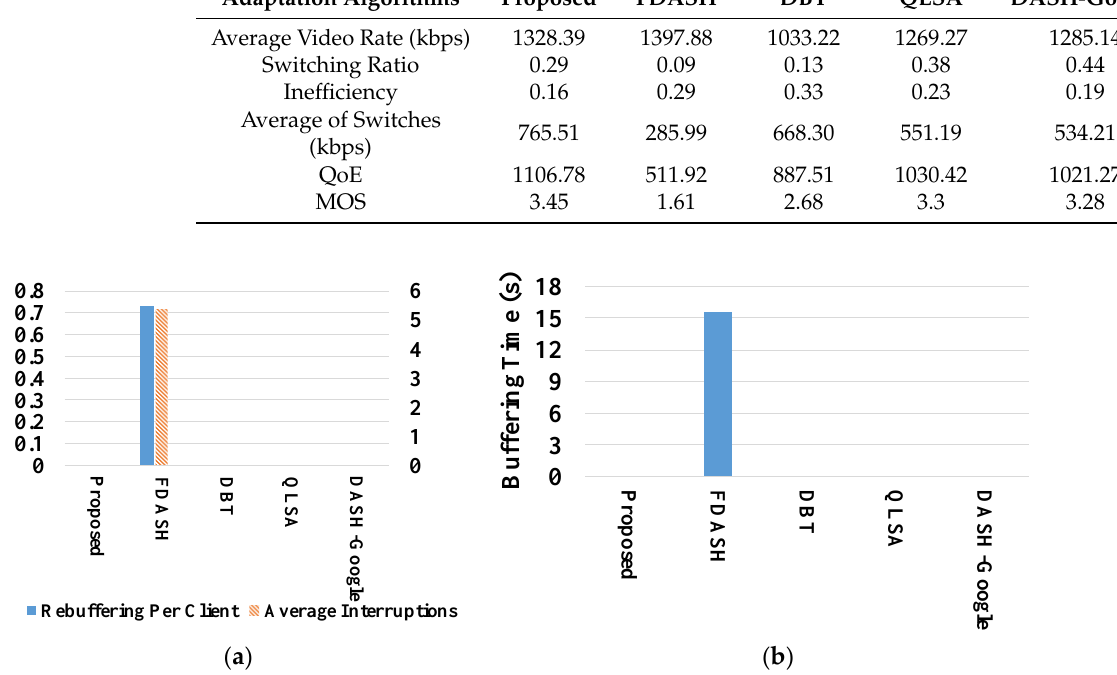
Table 6. Performance of algorithms at a buffer size of 60 s and a segment duration of 4 s. Adaptation Algorithms